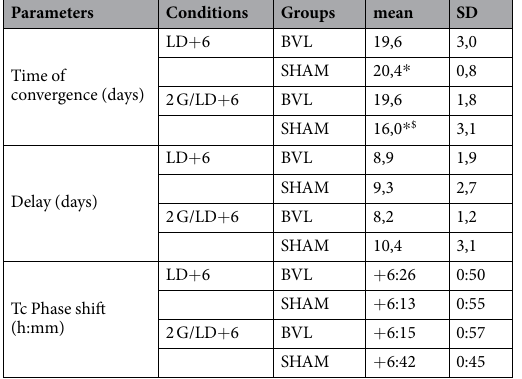
Table 1. Mean and SD values of the extended COSINOR method. * indicates a significant difference between conditions within groups. $ indicates a significant difference between groups within conditions.